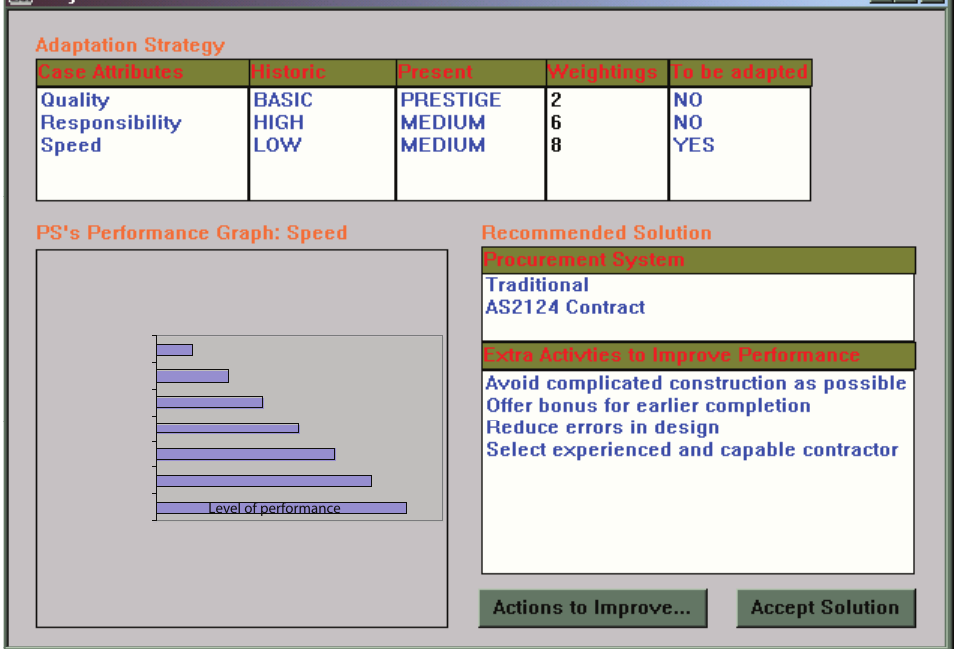
Figure 10: Critic-based adaptation at procurement selection